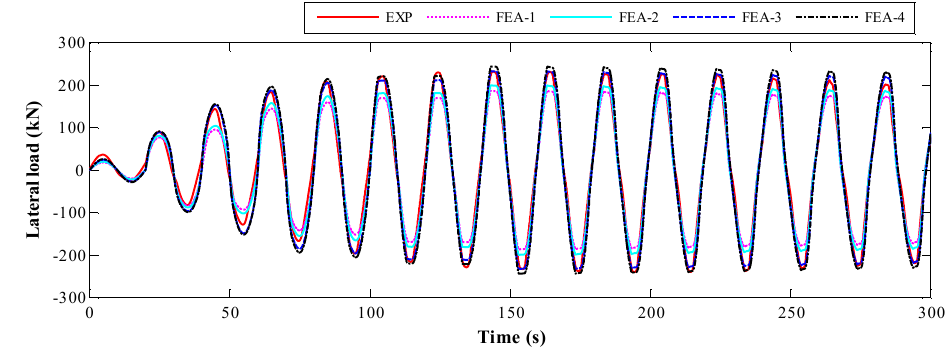
Figure 7. The time-history of the lateral load.